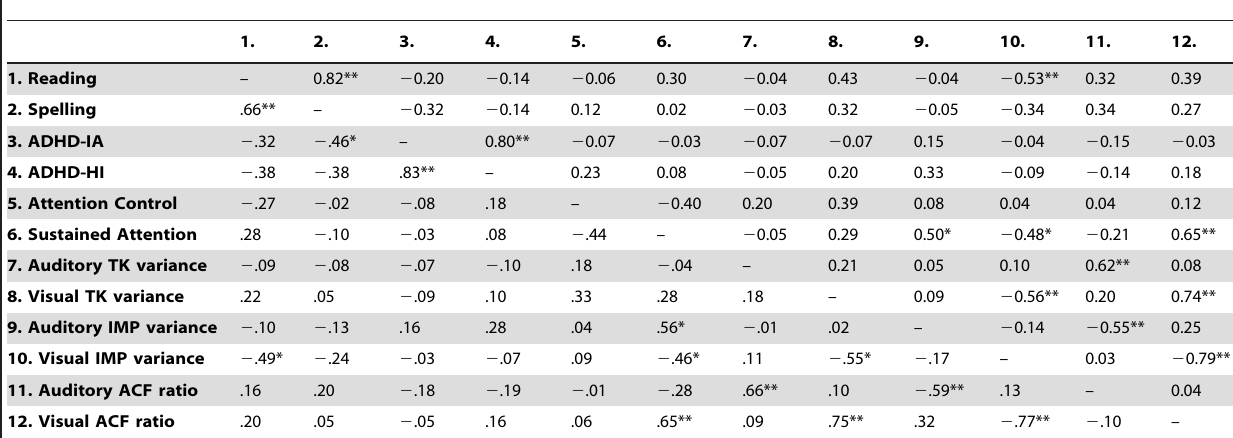
Table 2. Pearson’s product moment correlations and partial